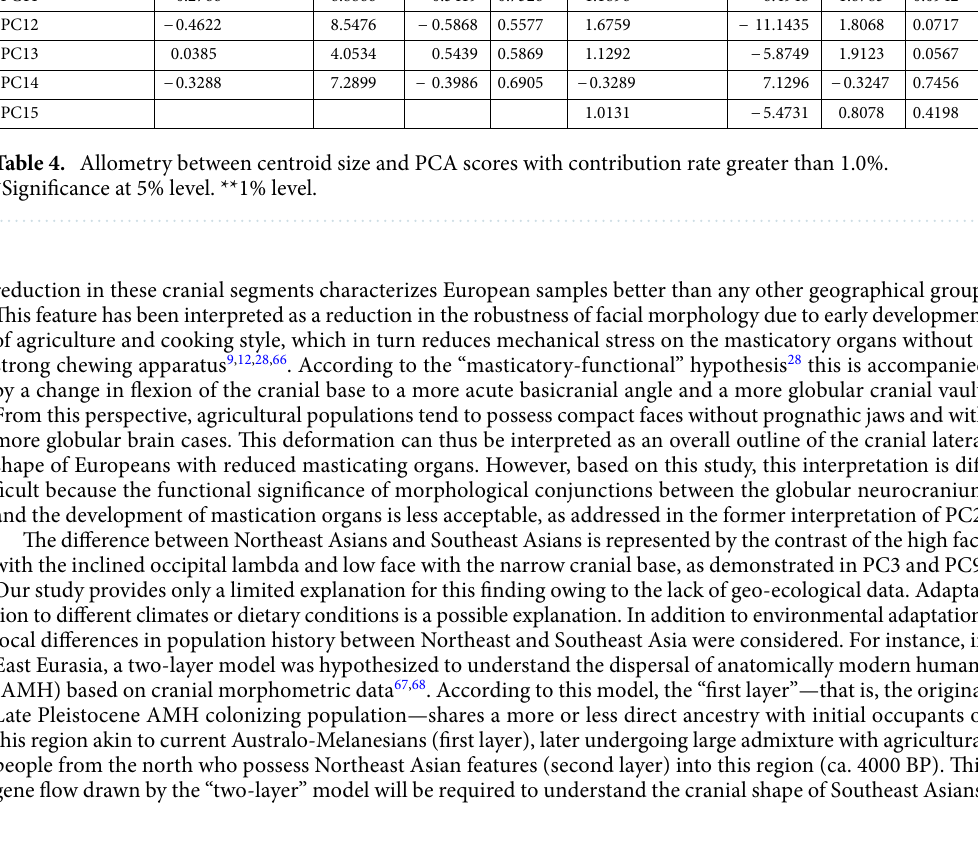
Table 4. Allometry between centroid size and PCA scores with contribution rate greater than 1.0%. *Significance at 5% level. **1% level.